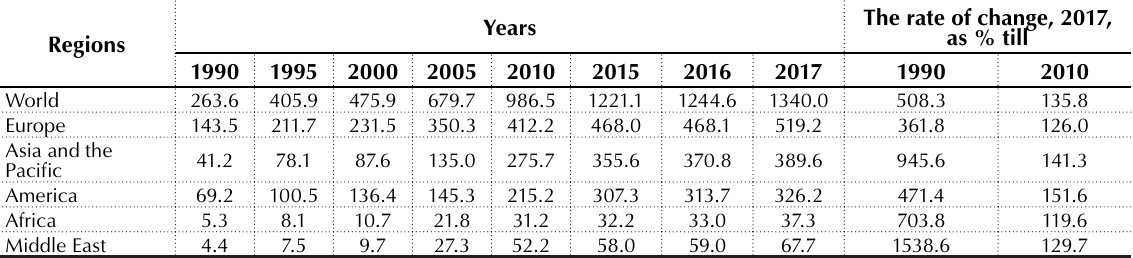
Table 2. International tourism receipts, 1990–2017 (billion US dollars) Source: Build by the authors based on the materials from Tourism Highlights (2018).